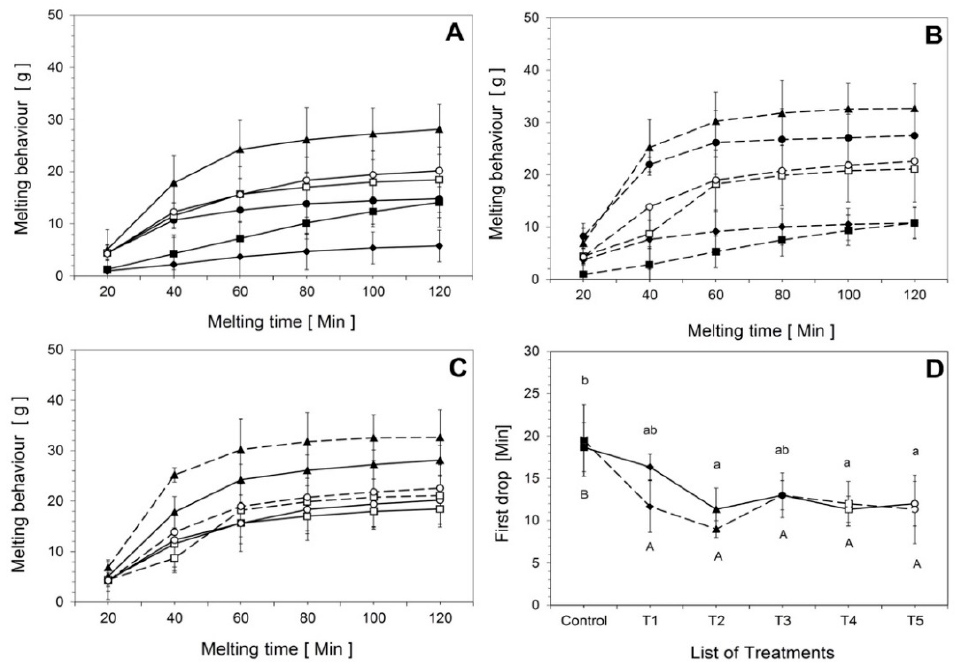
Figure 2. Melting behavior of ice cream treatments: Control ( (cid:4) ), T1 ( (cid:7) ), T2 ( (cid:78) ), T3 ( • ), T4 ( (cid:3) ), and F5 ( ) for both process designs. Relationship between time and melting behavior: ( A ) solid line (—) represents PH, ( B ) dotted line (- - -) represents HP, ( C ) treatments with only MWPs and eMWPs, and ( D ) time until the first drop of melted ice cream at a room temperature of 20 ± 2 ◦ C. The product temperature started from − 15 ± 2 ◦ C. Different letters (a,b) for PH and (A,B) for HP on top of the bars indicate significant differences at p < 0.05. The same letter indicates that the products are not significantly different from each other. Error bars indicate the standard deviation. See Table 1 for the definitions of treatment abbreviations. Table 3. Color properties of all treatments with and without microparticulated whey proteins, including the control sample.